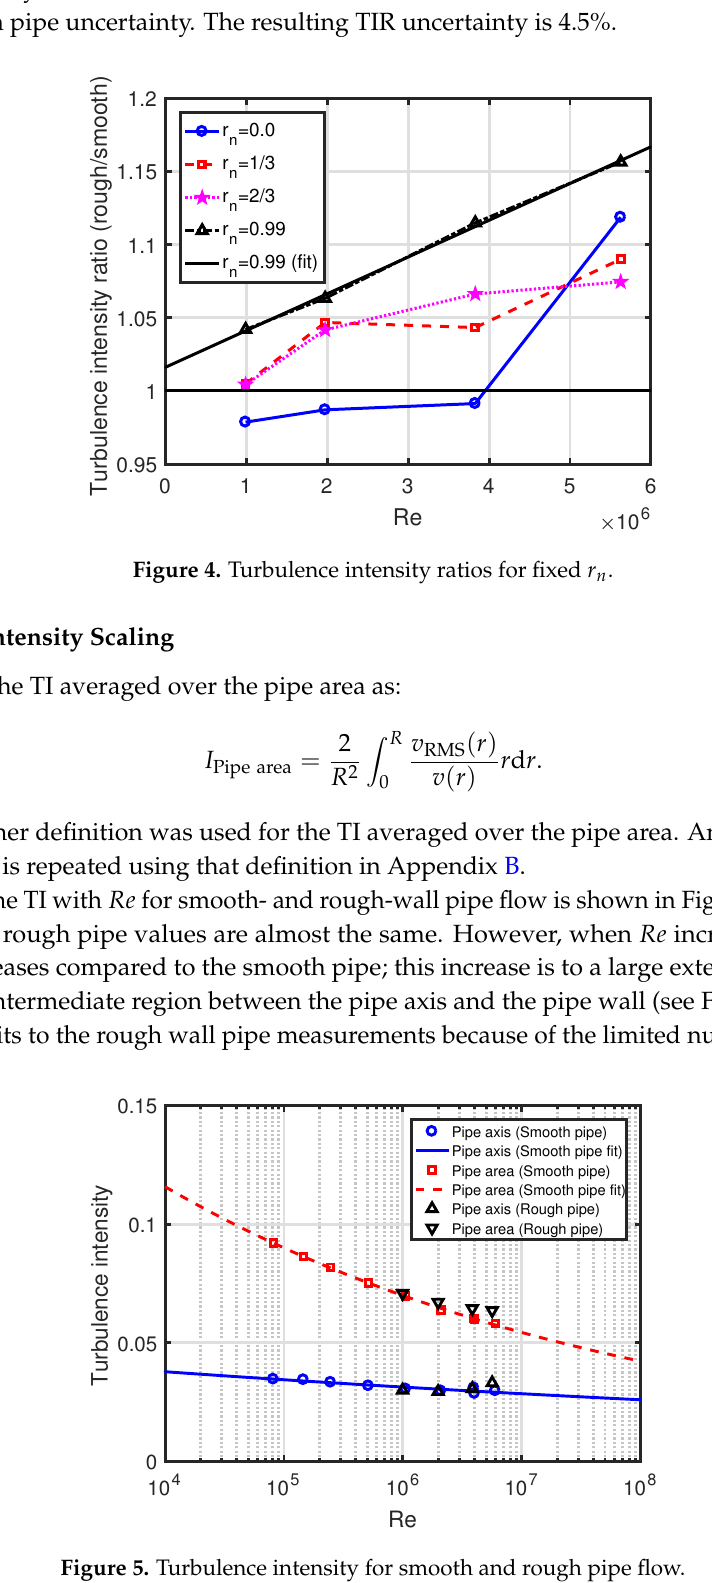
Figure 5. Turbulence intensity for smooth and rough pipe